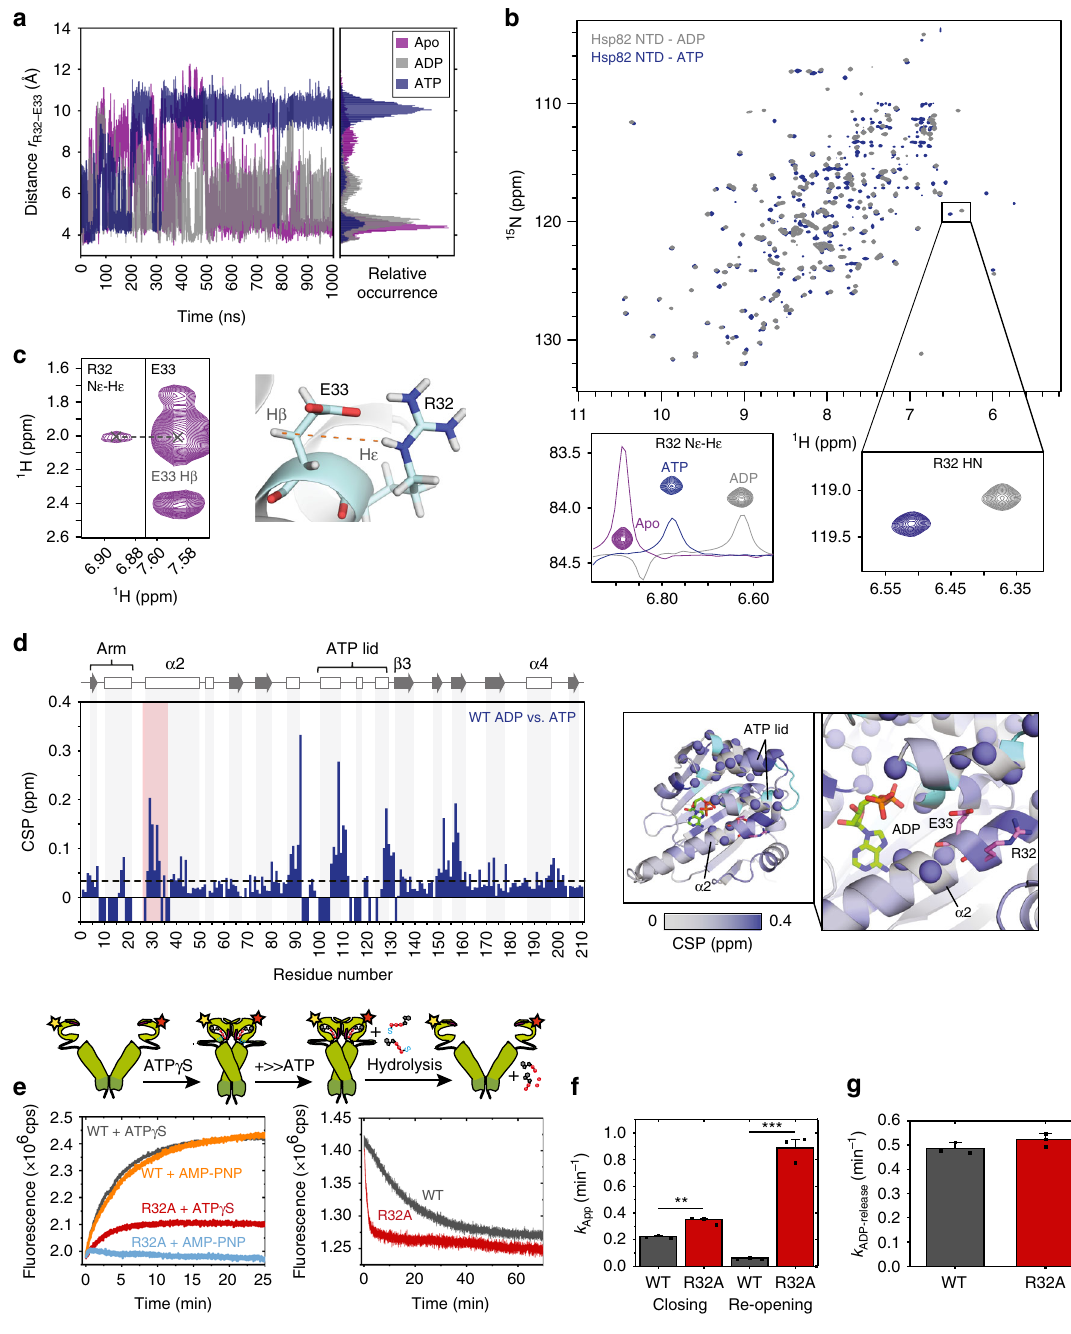
Fig. 4 Biophysical characterization of Hsp90. a Arg-32/Glu-33 distance from classical atomistic MD simulations, showing that the ion pair is closed in the apo-form (purple) of the Hsp90-NTD and its conformation is sensitive to nucleotide binding (ADP in grey/ATP in blue). b 1 H- 15 N-HSQC spectra of the Hsp90-NTD bound to ADP (grey) and ATP (blue), with close-ups of the resonances corresponding to the Arg-32 amide group (bottom right) and its sidechain H ε -N ε (bottom left), for which the 1 H traces are also included (apo shown in purple). c NOE cross-peak between Arg-32 H ε and Glu-33 H β in the apo-NTD, con fi rming the spatial proximity of the sidechains. d Left: chemical shift perturbations (CSPs) of the Hsp90-NTD bound to ADP and ATP. Negative bars represent residues that could not be assigned due to conformational dynamics. Secondary structure elements are shown on the top and altered residues next to Arg-32 are highlighted in red. Right: distribution of CSP on the NTD for ATP/ADP exchange. Amides of residues that are not visible due to conformational dynamics are represented by blue spheres, whereas unassigned residues are shown in cyan. e FRET experiments show that closing (left) in Hsp90-R32A (in red and light blue) takes place to a smaller extent in comparison with the wild type (WT, in black and orange). Right: re-opening of the closed dimer takes place faster in Hsp90-R32A (red) than in WT Hsp90 (black). The schematic fi gure on the top illustrates the experimental procedure. f Rates for closing and re-opening of WT Hsp90 and Hsp90-R32A obtained from mono-exponential fi tting of the FRET curves shown in e . Error bars represent SD from three independent measurements ( n = 3), shown as black dots. Statistical signi fi cance was assessed using a two-sided two-sample t -test and a level of signi fi cance of 0.01 (**) and 0.001 (***). The fi t yields a higher closure rate for R32A relative to WT Hsp90. g ADP-release assays show that WT Hsp90 and Hsp90-R32A have similar global ATP turnover. Error bars represent SD from three independent measurements ( n = 3), shown as black dots. Source data are provided as a source data fi